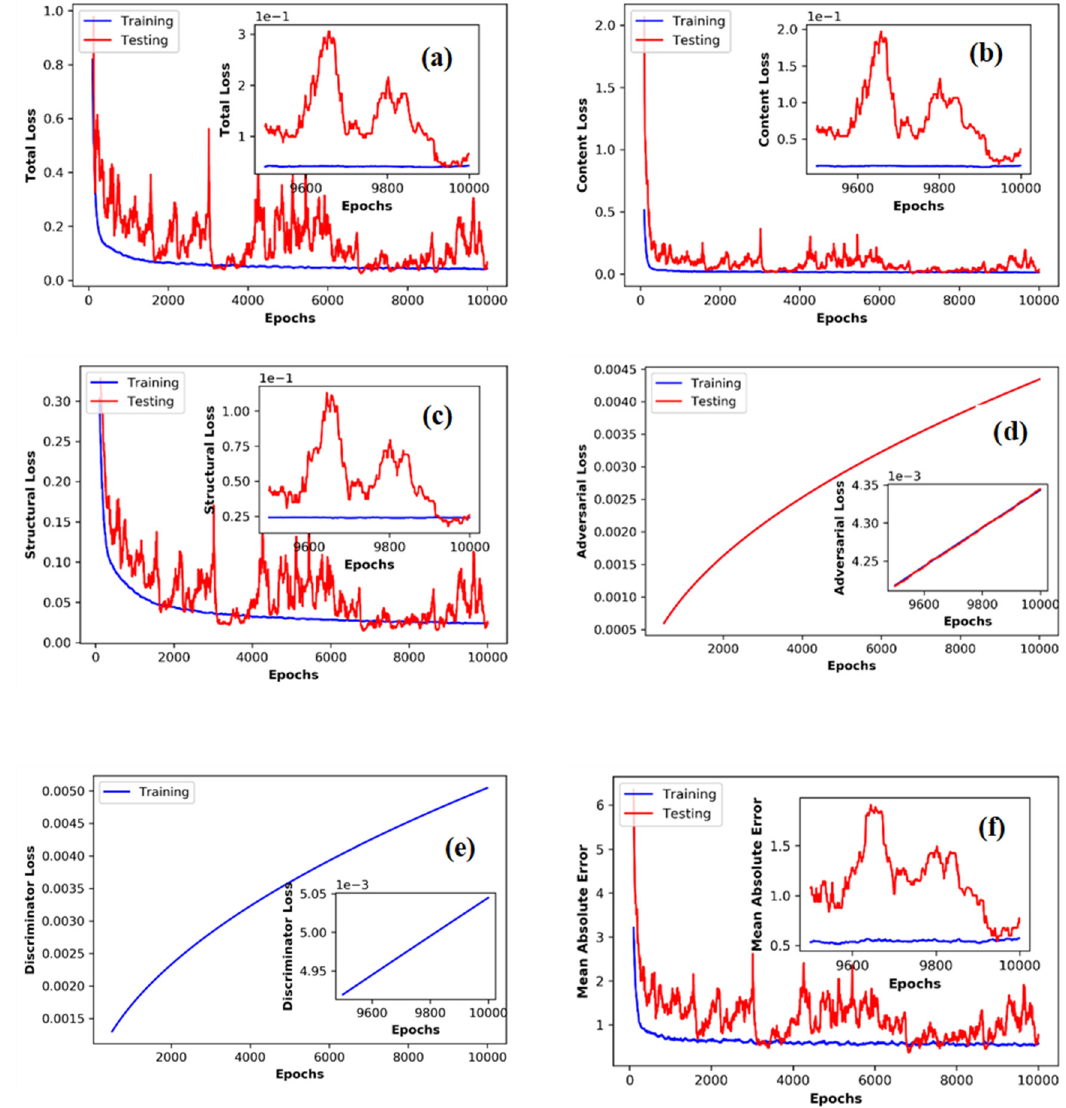
Figure 5. ( a ) Total loss of training, ( b ) content loss, ( c ) structural loss, ( d ) adversarial loss, ( e ) discriminator loss, ( f ) mean absolute error of the training.